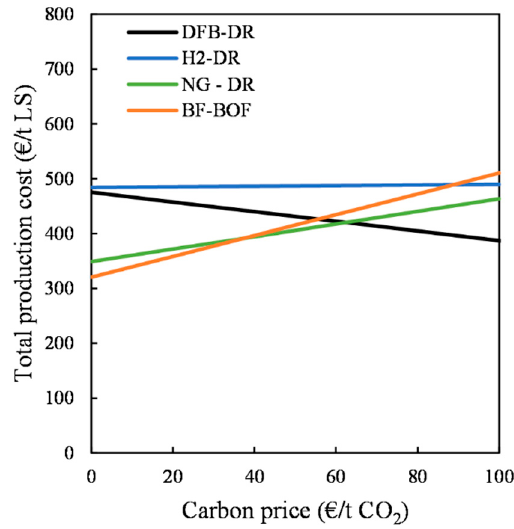
Figure 8. Total production costs of the three DR routes and the BF–BOF route, as a function of the carbon price, assuming that the revenues accrued from negative carbon emissions are equal (in EUR/t CO 2 ) to the price for emitting CO 2 . The assumed prices for biomass and electricity are 20 EUR/MWh and 40 EUR/MWh, respectively.